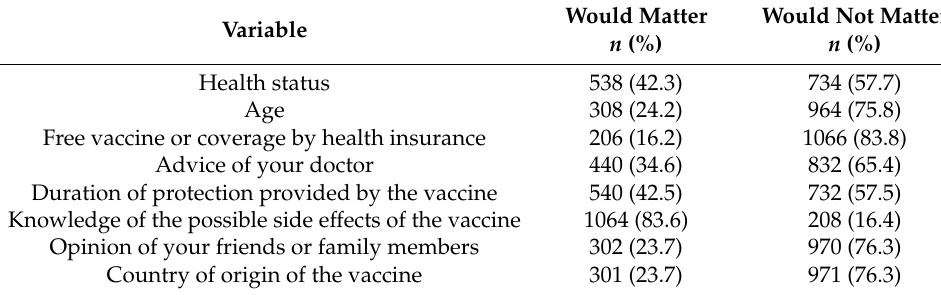
Table 3. Factors influencing COVID-19 vaccination acceptance ( n =